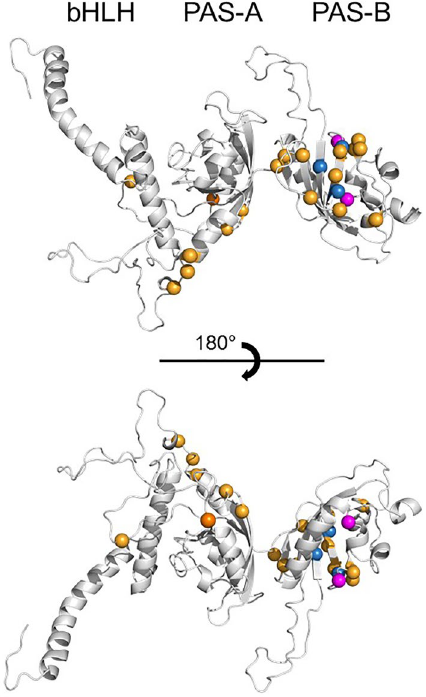
Figure 5. Structural model of the amino-terminal half of actinopterygian HIF2α showing sites putatively under positive selection. Twenty-three residues potentially under positive selection (MSA Codons 219–577, Table 3) mapped to a structural model of the N-terminal half of HIF2α based upon mouse HIF2α 50 . Two residues shown as purple spheres make contacts at the dimer interface between HIF2α and HIFβ and three residues shown as blue spheres contact an anti-cancer drug (0X3) known to interfere with subunit dimerization in mammals 50 . Eighteen other residues potentially under positive selection are shown as orange spheres. The upper and lower images are rotated by 180° around the indicated plane. Conserved DNA-binding (bHLH) and protein dimerization (PAS-A, PAS-B) domains are indicated at the